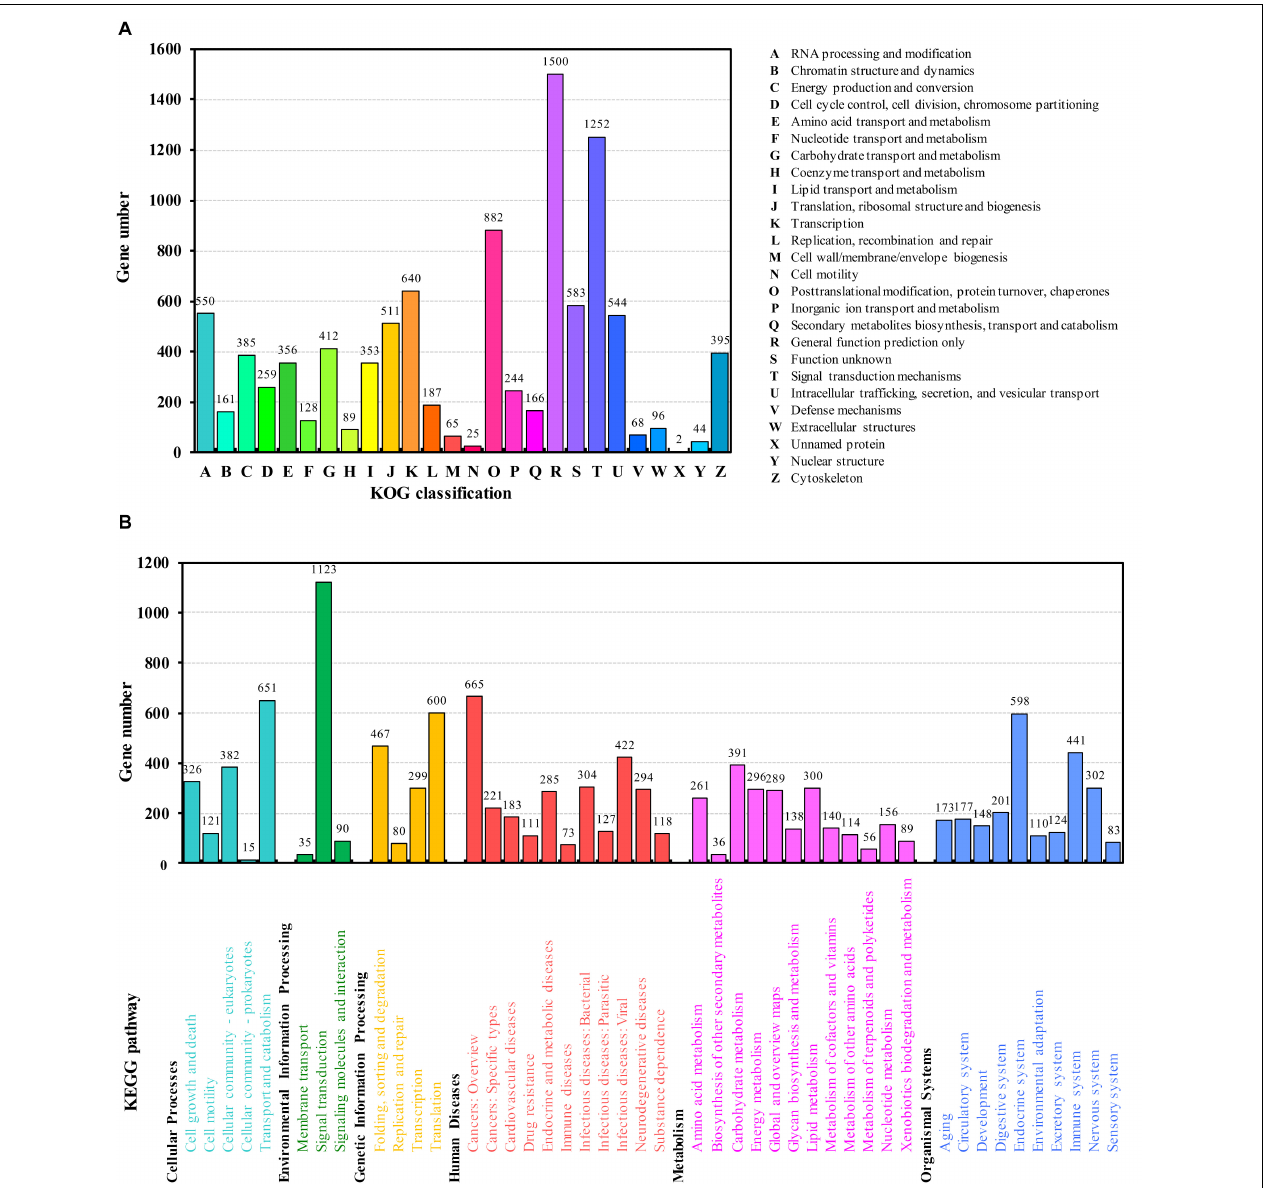
FIGURE 2 | Functional annotation using the KOG (A) and KEGG databases (B)